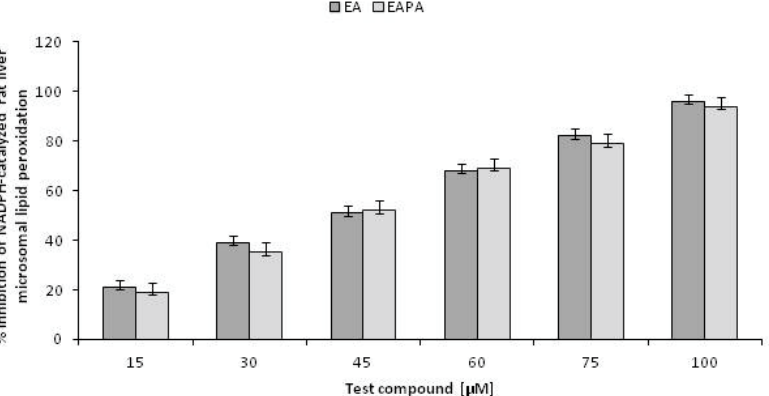
Figure 3. Effect of different concentration of EA and EAPA on NADPH-dependent lipid peroxidation in rat liver microsomes. Data represent mean ± S.D. from three independent experiments performed in triplicates, no significant differences were observed between EA and EAPA activities in all cases.